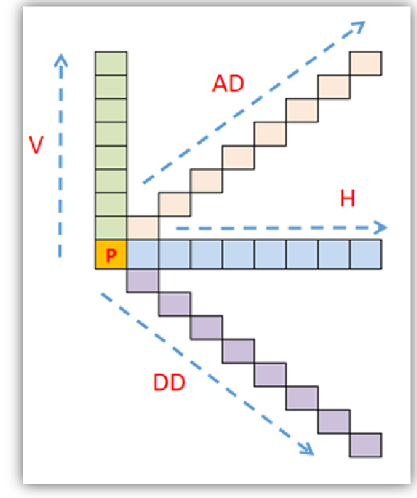
Fig. 3. The process of calculating the histogram